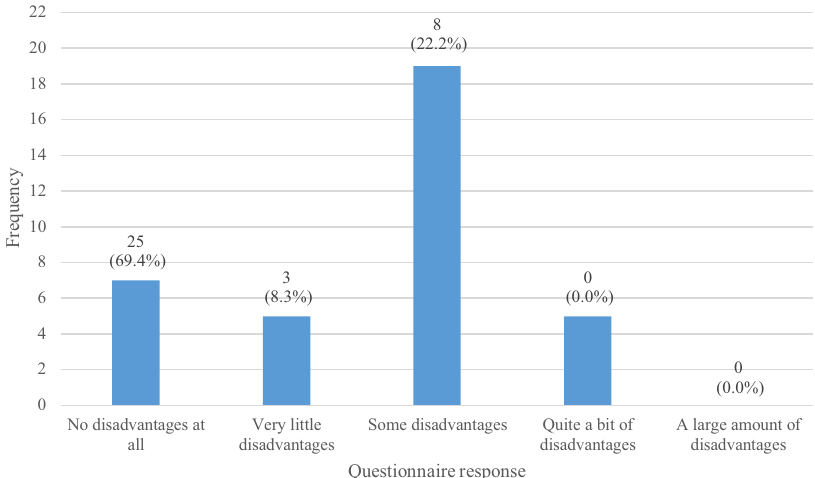
Fig. 2 Disadvantages of My Breathing Matters. Participant responses to single item on My Breathing Matters Satisfaction Questionnaire relating to disadvantages of using My Breathing Matters.